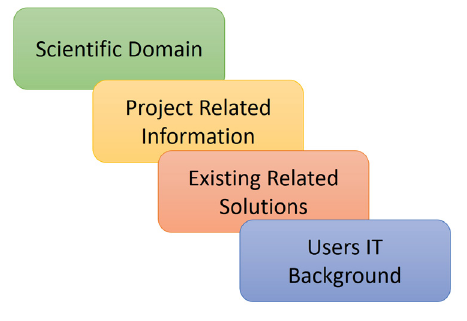
Figure 7. Conceptual software design and modeling. This is the 3 rd step of the top layer in the butterfly